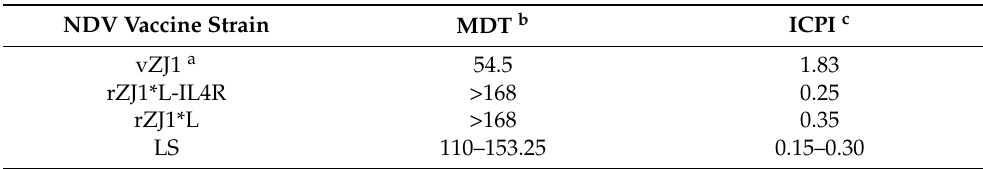
Table 1. Mean death time (MDT) and intracerebral pathogenicity index (ICPI) of lentogenic NDV vaccine strains and vNDV challenge strain.